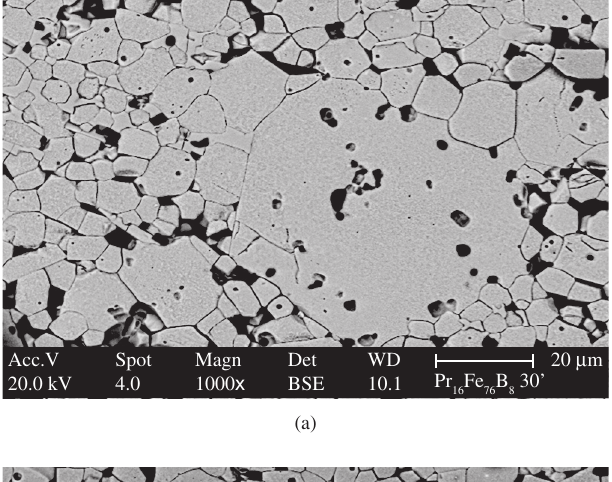
Figure 1. Variation of remanence and intrinsic coercivity with milling speed for 1.8 ks milling time.